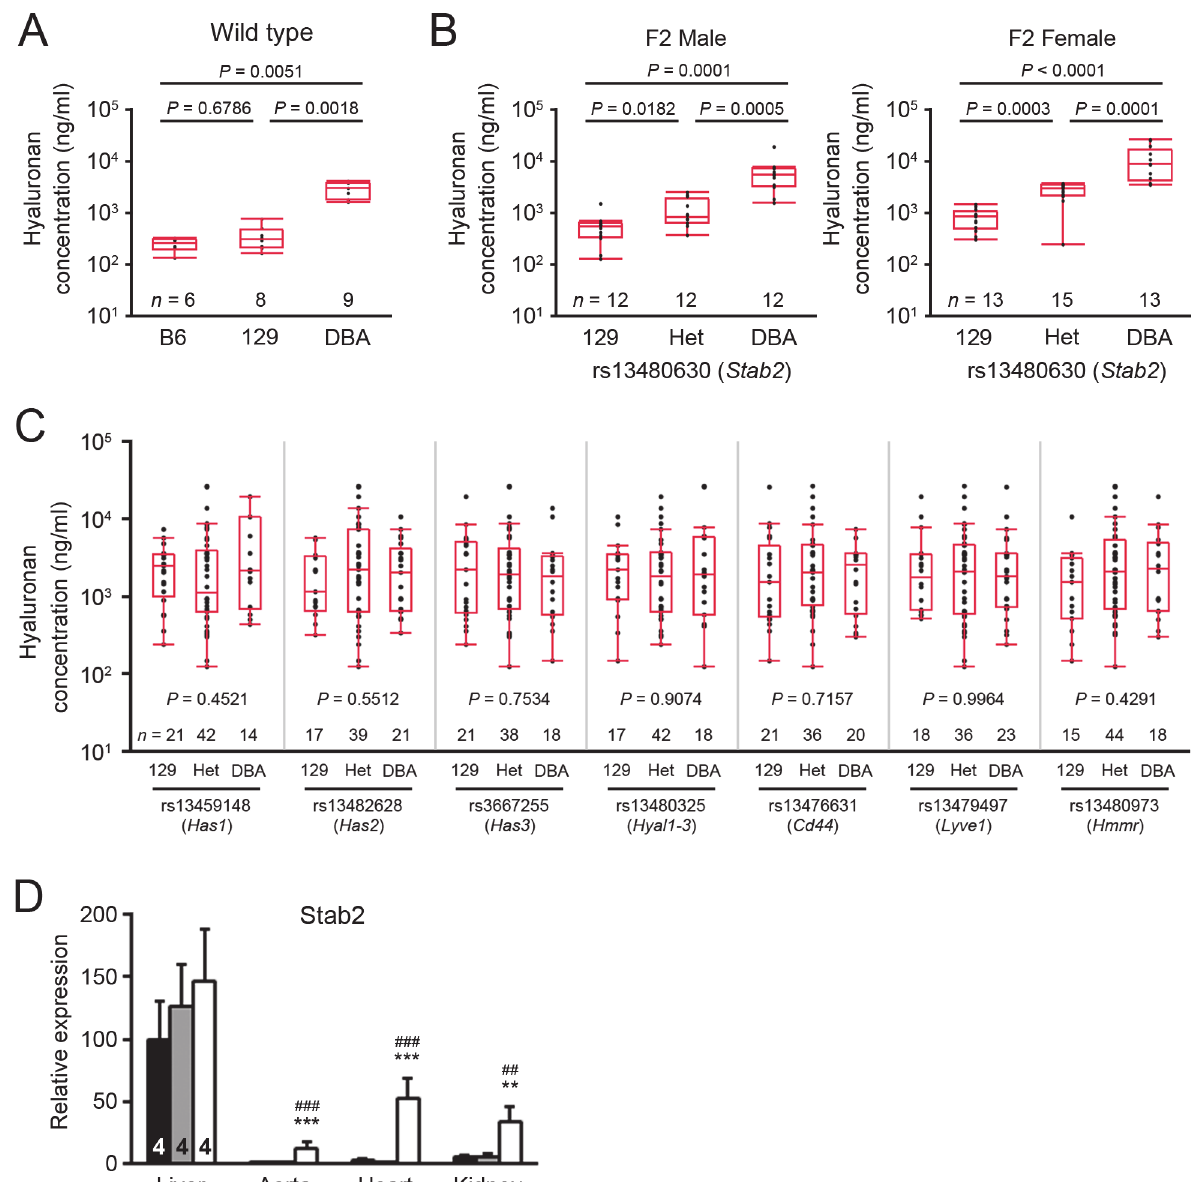
Fig 5. DBA-allele dependent upregulation of Stab2 and its ligand hyaluronan. (A) Plasma hyaluronan concentrations in the wild-type male C57BL/6, 129S6 and DBA2/J mice. Box-and-whisker plots: midline, median; box, 25th and 75th percentiles; whiskers, 1.5× interquartile range; dots, outliers. Numbers of mice were indicated below the plots. (B) Plasma hyaluronan concentrations in a subset of F2 males and females of 129-apoE × DBA-apoE. Mice were grouped by the genotype of rs13480630 on Chr 10, which is located near Stab2 . Differences were compared by Kruskal – Wallis test followed by Steel-Dwass test for (A) and (B). (C) Effects of other hyaluronan metabolic loci on plasma hyaluronan concentrations. The same set of F2 population was grouped into 129-homo, Hetero and DBA-homo according to the genotype of rs13459148 on Chr 17 (near Has1 ), rs13482628 on Chr 15 (near Has2 ), rs3667255 on Chr 8 (near Has3 ), rs13480325 on Chr 9 (near Hayl1 – 3 ), rs13476631 on Chr 2 (near Cd44 ), rs13479497 on Chr 7 (near Lyve1 ) and rs13480973 on Chr 11 (near Hmmr ). Kruskal – Wallis test was used for the multiple comparison. (D) Expression levels of Stab2 in various tissues from B6 (black filled bars), 129 (gray filled bars) and DBA (open bars). Data are relative to those in the B6 liver (= 100) assessed by quantitative RT-PCR. ** P < 0.01, *** P < 0.001 vs. B6; ## P < 0.01, ### P < 0.001 vs. 129 (one-way ANOVA followed by Tukey-Kramer ’ s HSD test). Data were shown as the mean ± SD. Sample numbers were indicated in the